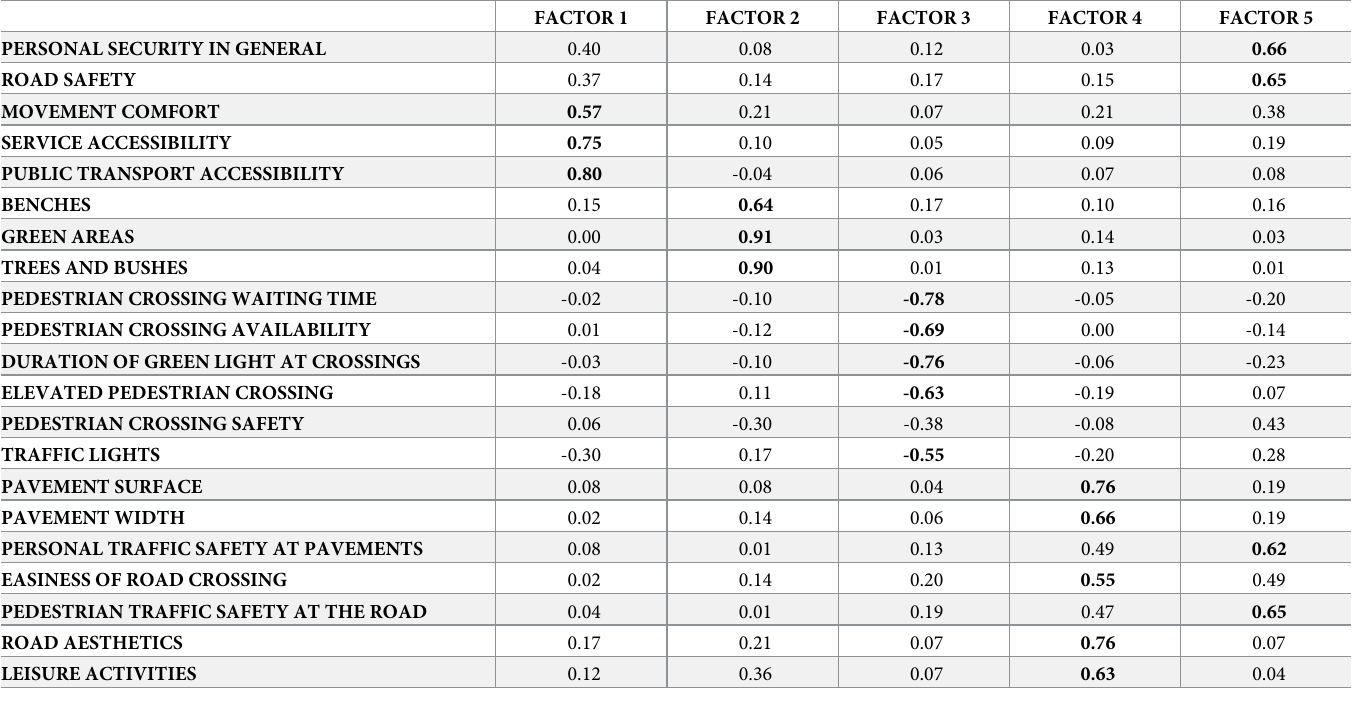
Table 4. Results of the factor analysis—Factor loadings for five possible variables affecting